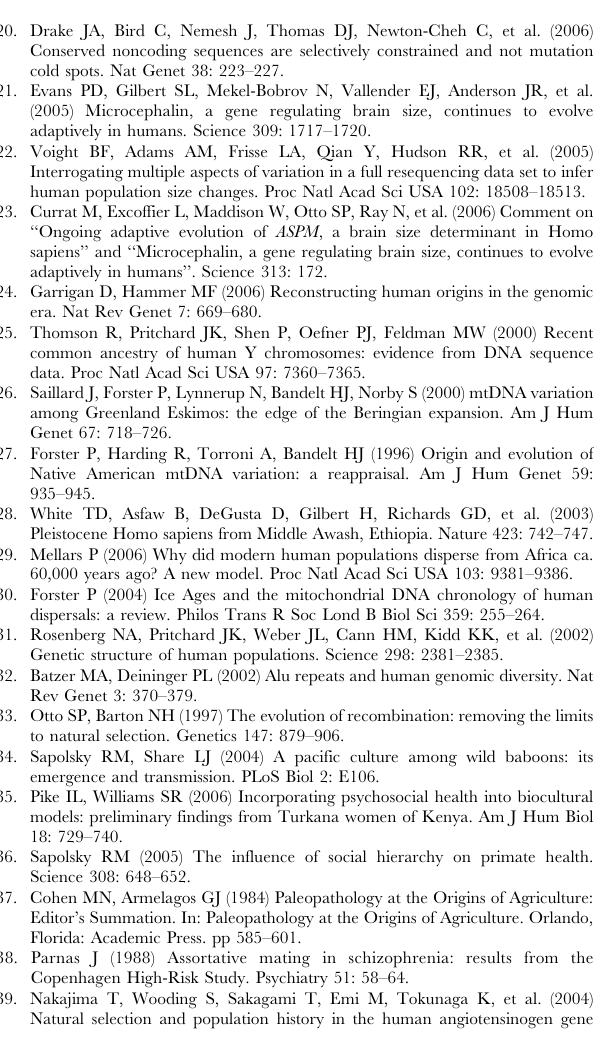
Figure S1 Sequence similarity between human and 7 non- human primates displayed by VISTA [55]. The sequences of chimpanzee and rhesus were obtained from the NCBI database. The DNA of the five other non-human primates were sequenced over this 1.8 Kb region in GABRB2 . Figure S2 An unrooted phylogenetic tree of Alu sequences. (A) The tree was generated from an alignment of the consensus sequences of Alu sub-families and the Yi6AH151 using DNA- PARS in the PHYLIP software package [57]. The consensus tree generated from 1,000 replications is labeled with bootstrap values at the nodes and displayed with TreeView [58]. The clade containing human-specific Alu Yi6AH151 and its closest neighbor Alu Yi6 is highlighted in grey. (B) Sequence alignment of Alu Yi6 consensus sequence and Yi6AH151. Refer to Salem et al. [14] for the sequences of all 150 members of Yi6 subfamily. Figure S3 Plot of estimated recombination rate and location of recombination hotspots in GABRB2 . The plot is adapted from